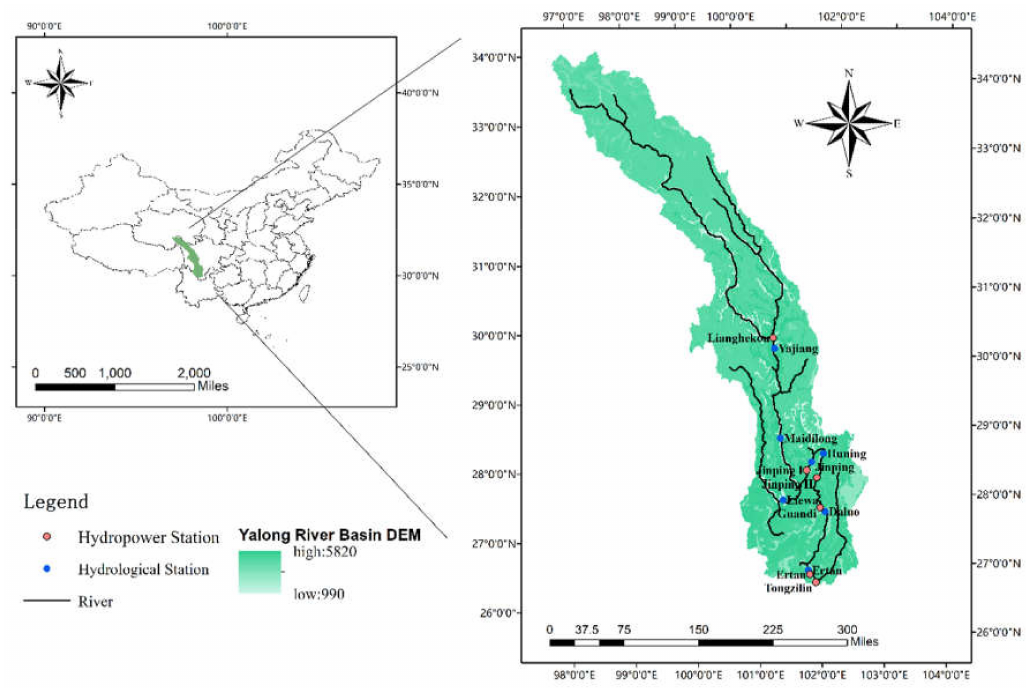
Figure 1. The Yalong River